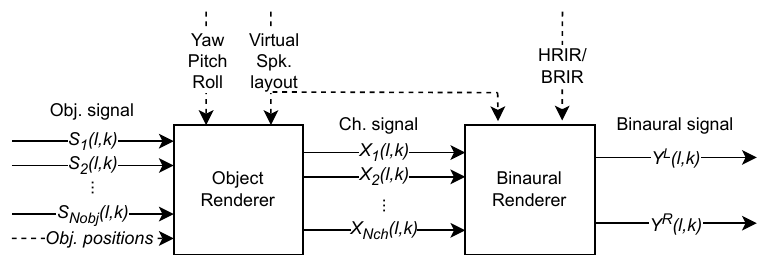
Figure 2. Block diagram of the VLR-based BR in MPEG-H 3DA. The normalized panning gain ˜ g i , m (= g i , m / (cid:107) g m (cid:107) p ) allows the maintenance of a